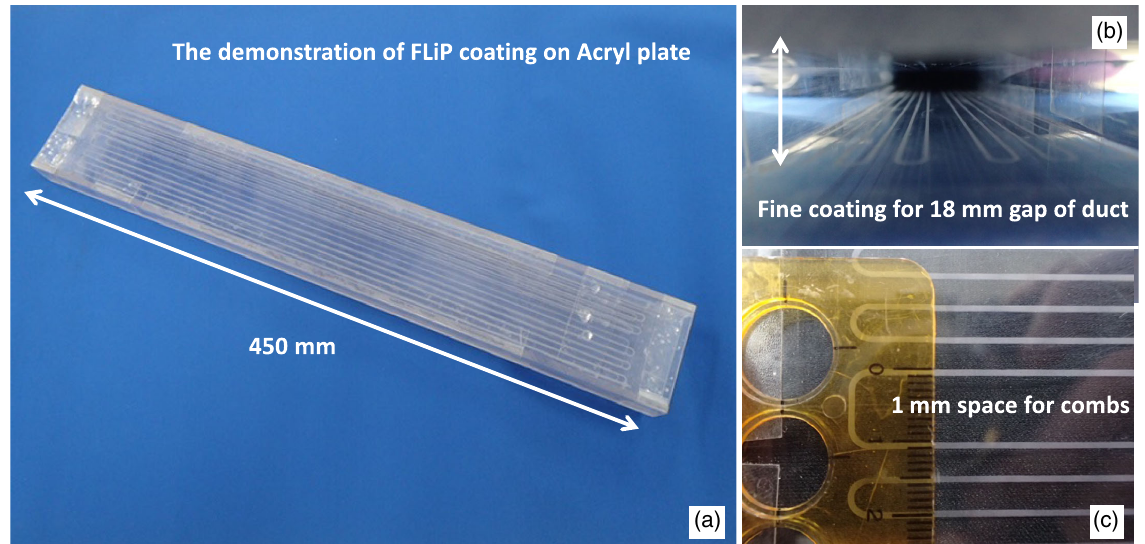
FIG. 15. Comb-tooth-patterned coating test using an acryl